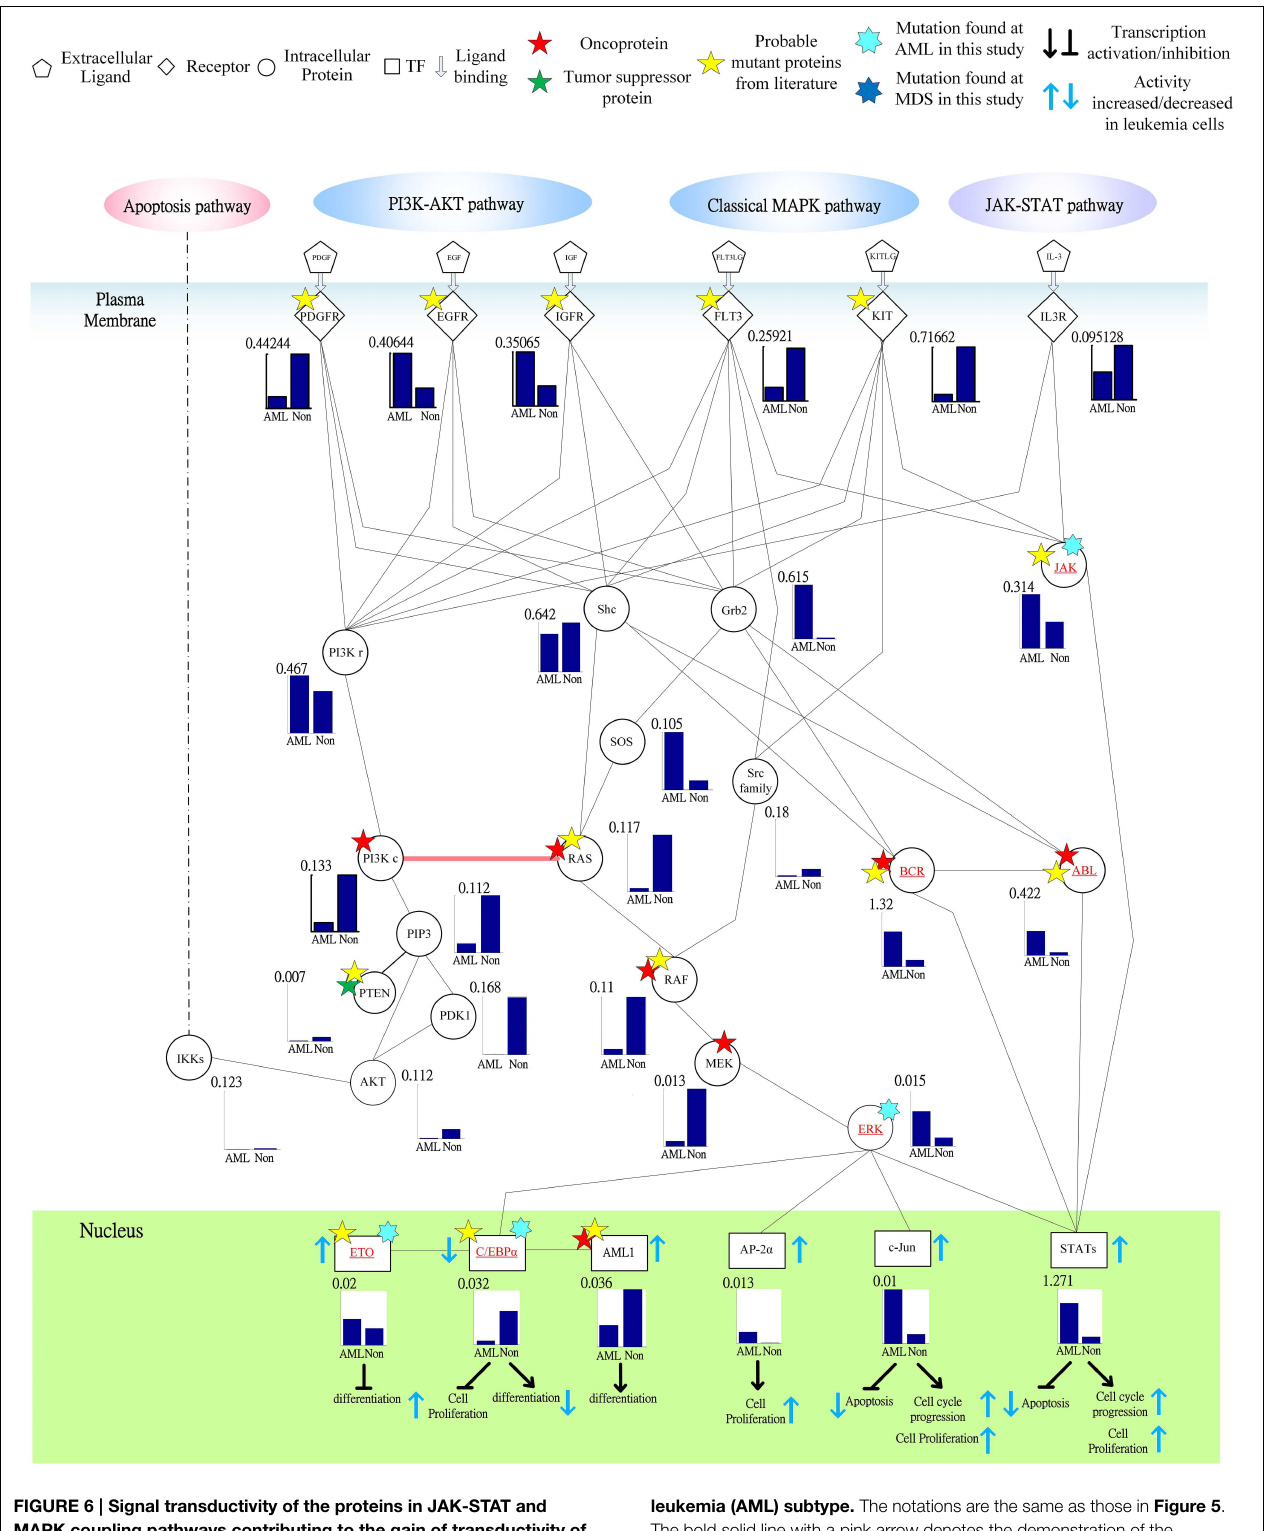
FIGURE 6 | Signal transductivity of the proteins in JAK-STAT and MAPK coupling pathways contributing to the gain of transductivity of STATs and the loss of transductivity of CEBP α at the acute myeloid